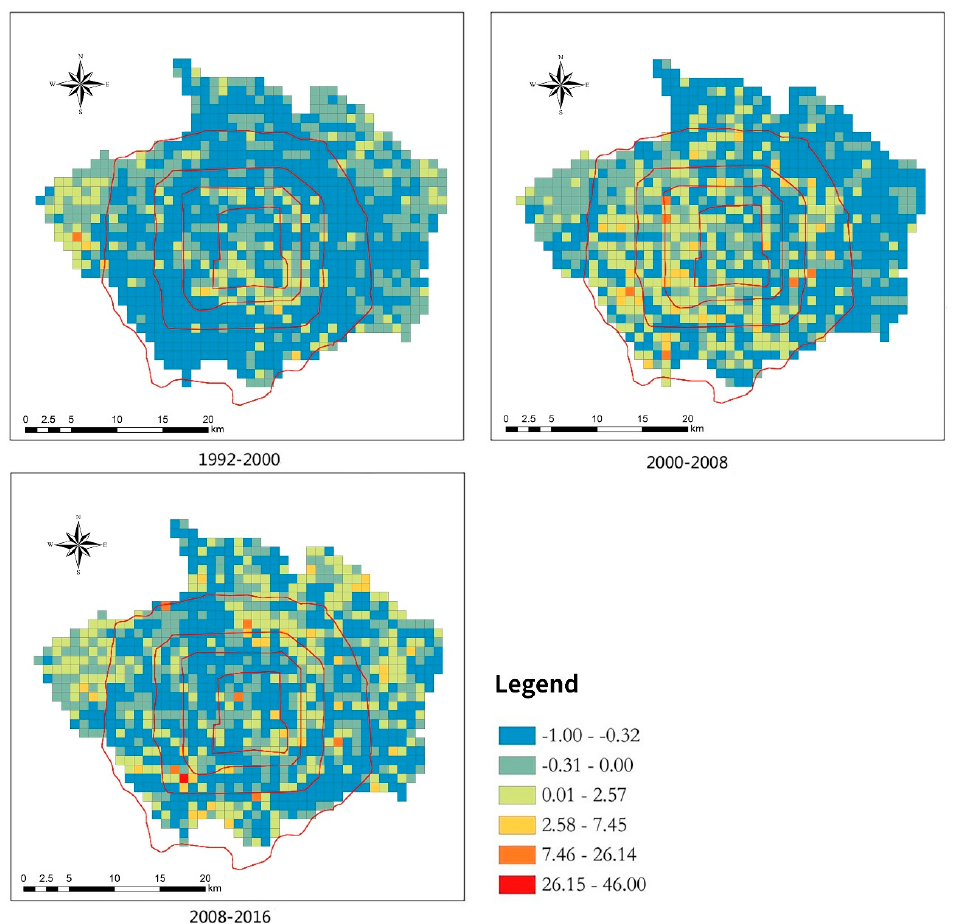
Figure 6. Changes in the largest patch index values of urban green spaces in central Beijing during the period 1992–2016.